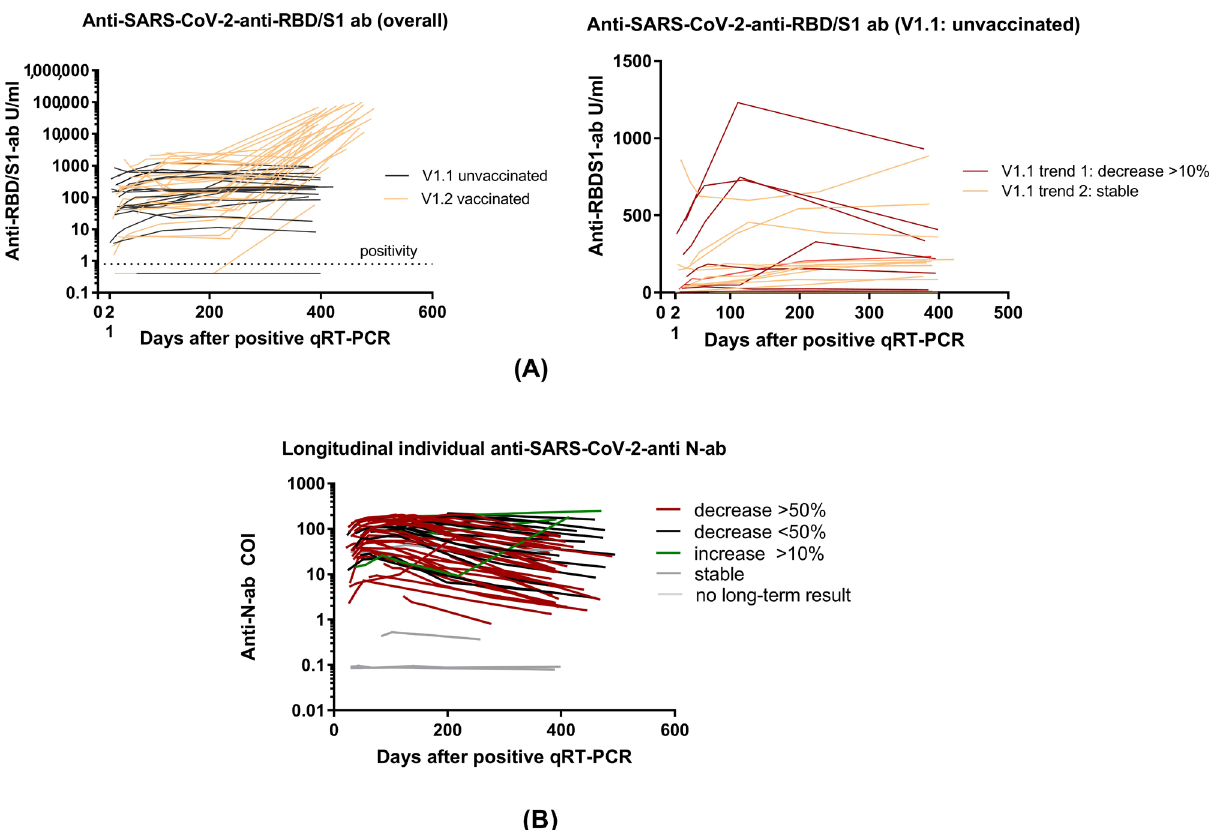
Figure 4. Individual longitudinal Anti-SARS-CoV-2-antibody dynamics. ( A ) Long-term individual anti-SARS-CoV-2-RBD/S1 antibodies in overall cohort differentiated between vaccinated and un- vaccinated subjects (left figure). V1.1 unvaccinated divided into trend 1 (decreasing antibodies) and trend 2 (increasing antibodies). ( B ) Long-term individual anti-SARS-CoV-2-N-antibodies (COI). A decrease of more than 50% is illustrated by the color red, a decrease < 50% by the color black, and an increase of >10% by the color green. Stable levels and subjects without long-term results are presented in gray.